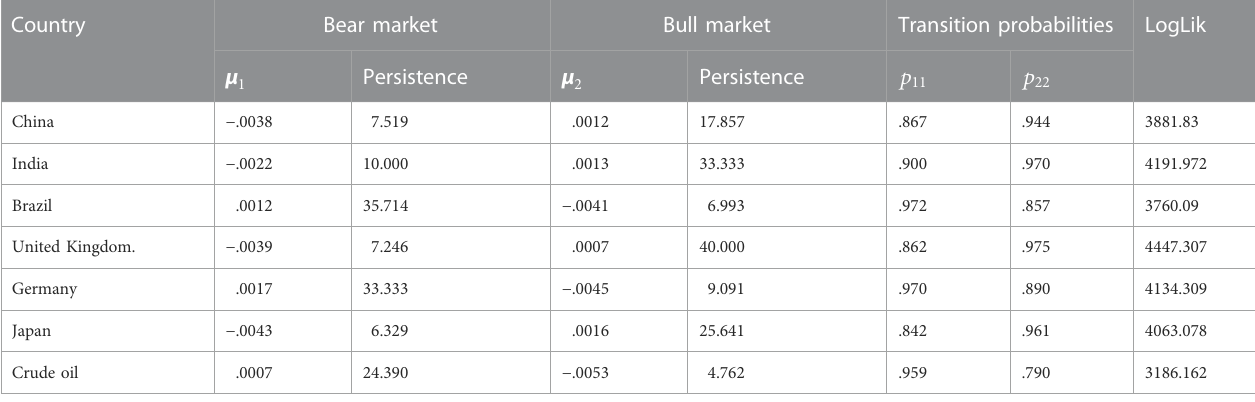
TABLE 3 Estimates for Markov regime switching model.